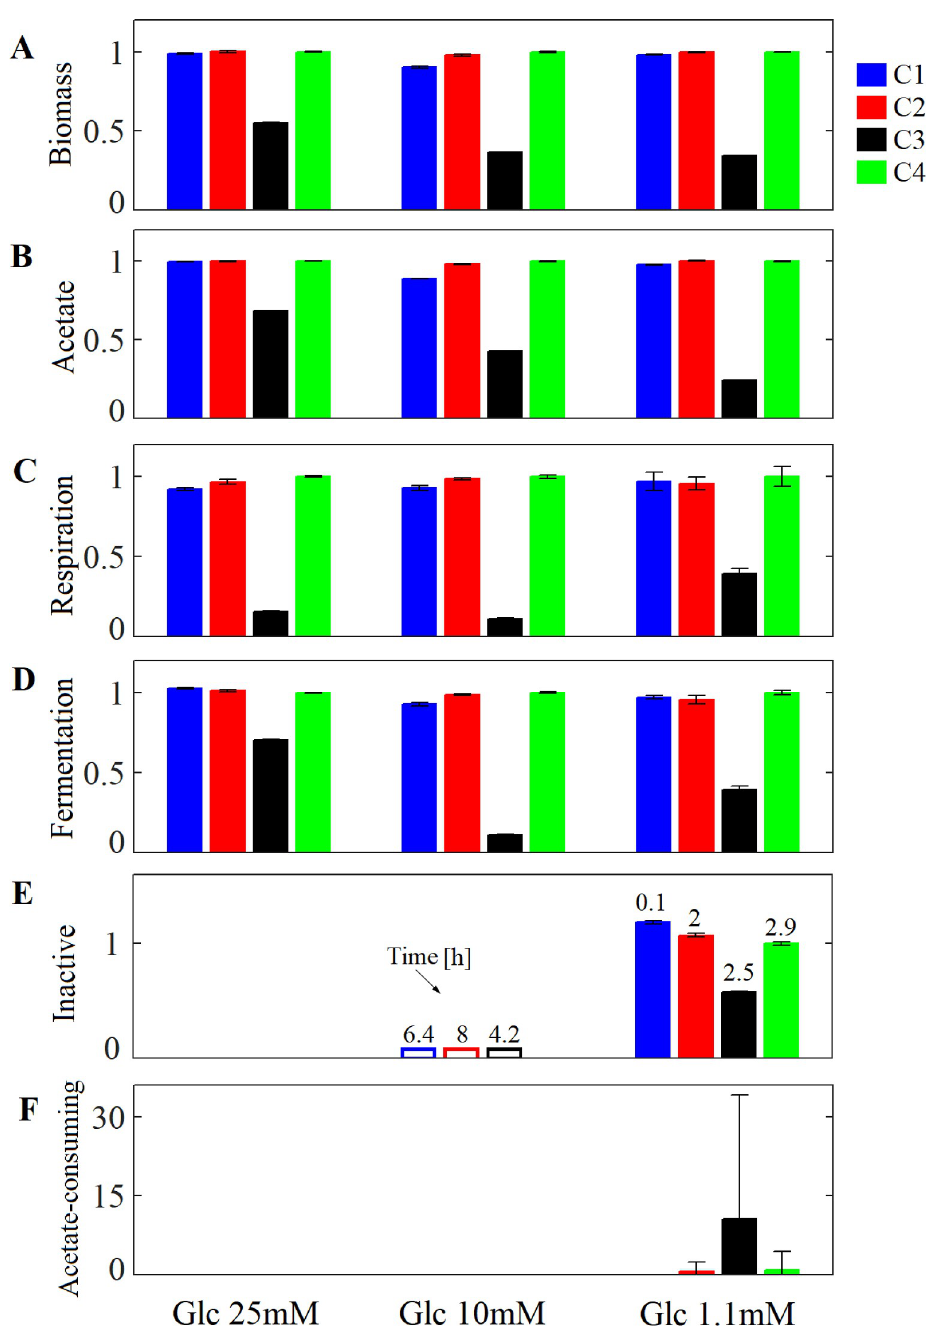
Fig 4. E . coli biofilm development at time 8.5 h with different glucose supplies and crowding assumptions using a square lattice. Three glucose supply (Glc) were tested: 25 mM, 10 mM and 1.1 mM. (A) Relative biomass computed as Biomass(obtained in each C)/Biomass(obtained in C4) at time 8.5 h. (B) Relative acetate computed as Acetate (produced in each C)/Acetate(in C4). Relative number of cells identified with phenotype (C) respiration: glucose + O 2 ➔ (acetate) + biomass, (D) fermentation: glucose ➔ acetate + biomass, (E) inactive cells, and (F) acetate consuming: acetate + glucose + O 2 ➔ biomass in each C compared to those obtained in C4. The number showed on bar plot (E) indicate the time in [h] when inactive cells appeared in the system. Inactive cells were not identified in C4 when glucose supply was set to 10mM. Crowding assumptions C1-4 are described in Table 2. Error bars show the standard deviation in three independent